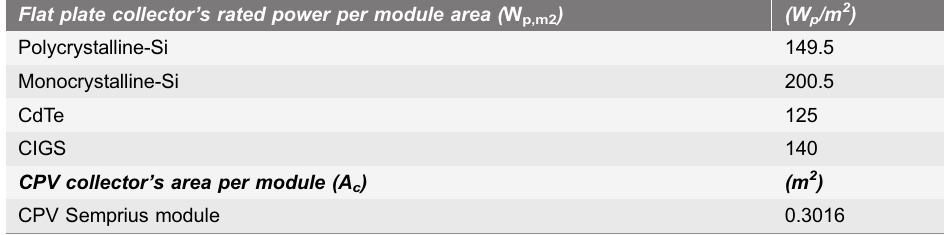
Table 3. Selected input parameters for PV